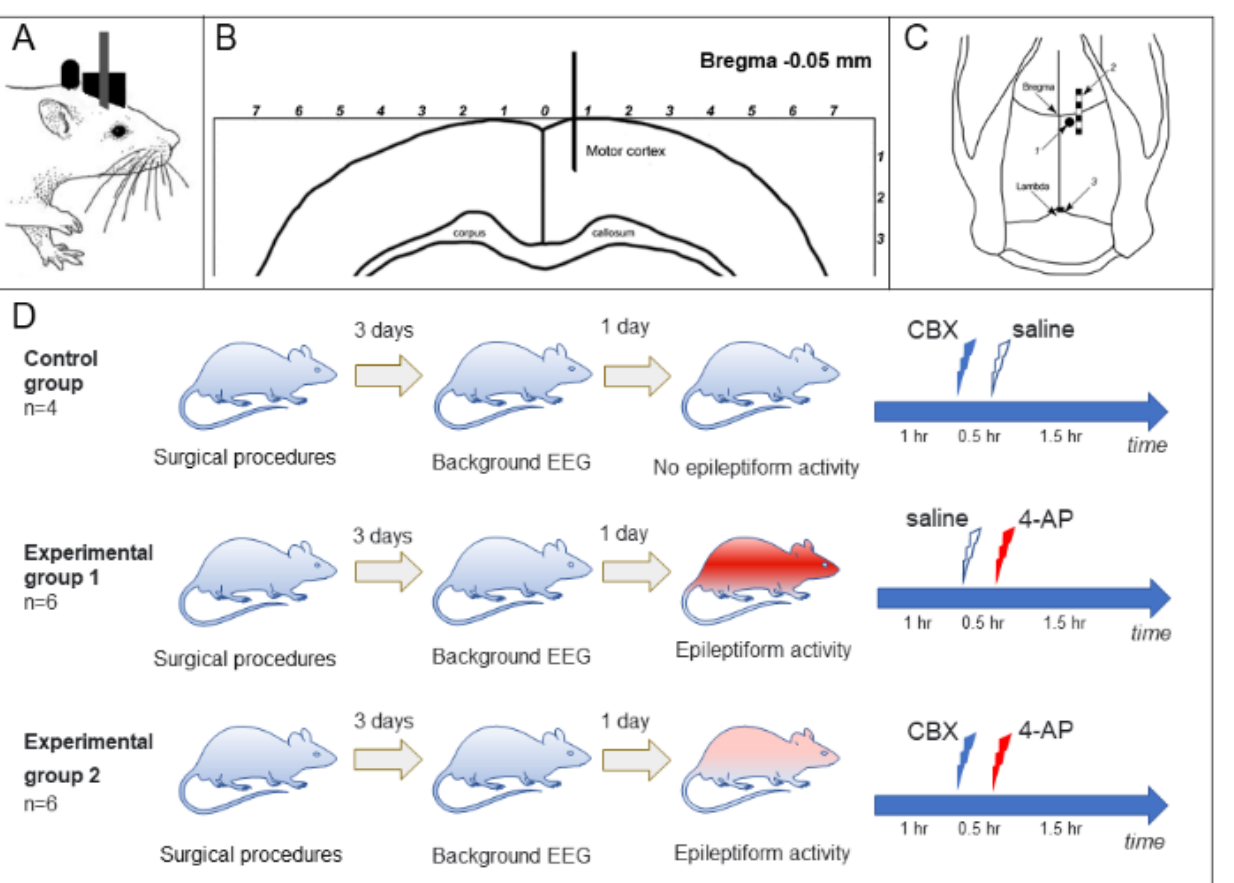
Figure 5. Experiment design: ( A ). The rat after surgical implantation; ( B ). The frontal view of the rat brain (modified from [41]); ( C ). The cannulas (1) and electrodes (2 and 3) location on the rat’s skull. ( D ). After surgical implantation of the electrodes and the cannula unit, the background ECoG was recorded, and analyzed 3 days later. CDX, the GJ blocker carbenoxolone, 50 mM, 4 µL; 4-AP, 4-aminopyridine, a K- channel inhibitor, 25 mM, 2 µL (for other explanations, see text). The carbenoxolone (CBX) molecule is polar and relatively large, so it has very poorly crossing the blood–brain barrier [42]. Other studies show that CBX does not cross the blood–brain barrier at all [43]. This applies to both intraperitoneal and intravenous CBX. In addition, CBX is metabolized differently in different parts of the body, and together produces a large number of different metabolites [42]. In any case, the system administration of CBX is inadequate for studying the effects on the targets in the central nervous system. 4-Aminopyridine (4-AP) is used intravenously and orally to relieve symptoms of Eaton–Lambert syndrome, multiple sclerosis, Huntington’s chorea, Alzheimer’s disease, and some other neurological disorders [44]. However, to obtain focal epileptic seizures,